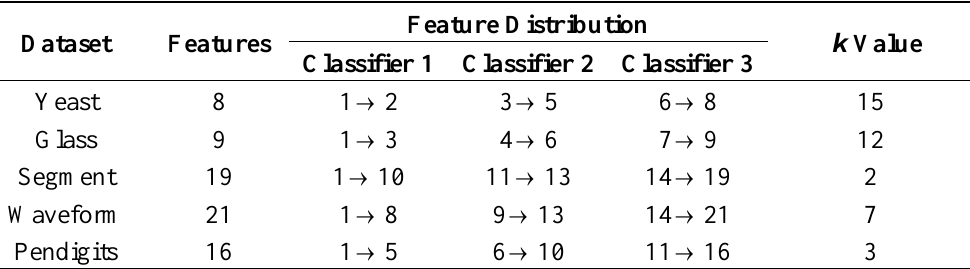
Table 7. Description of generating